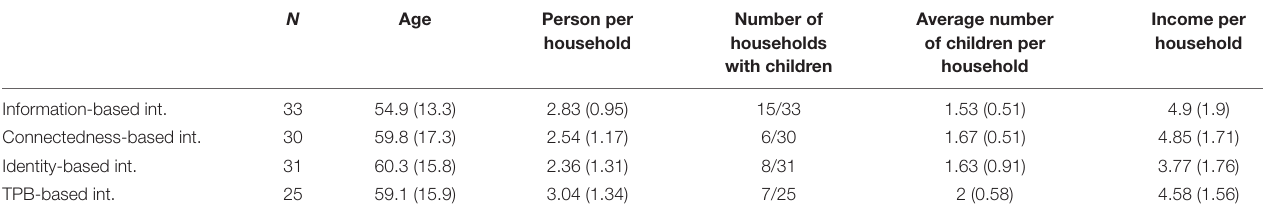
N Age Person per